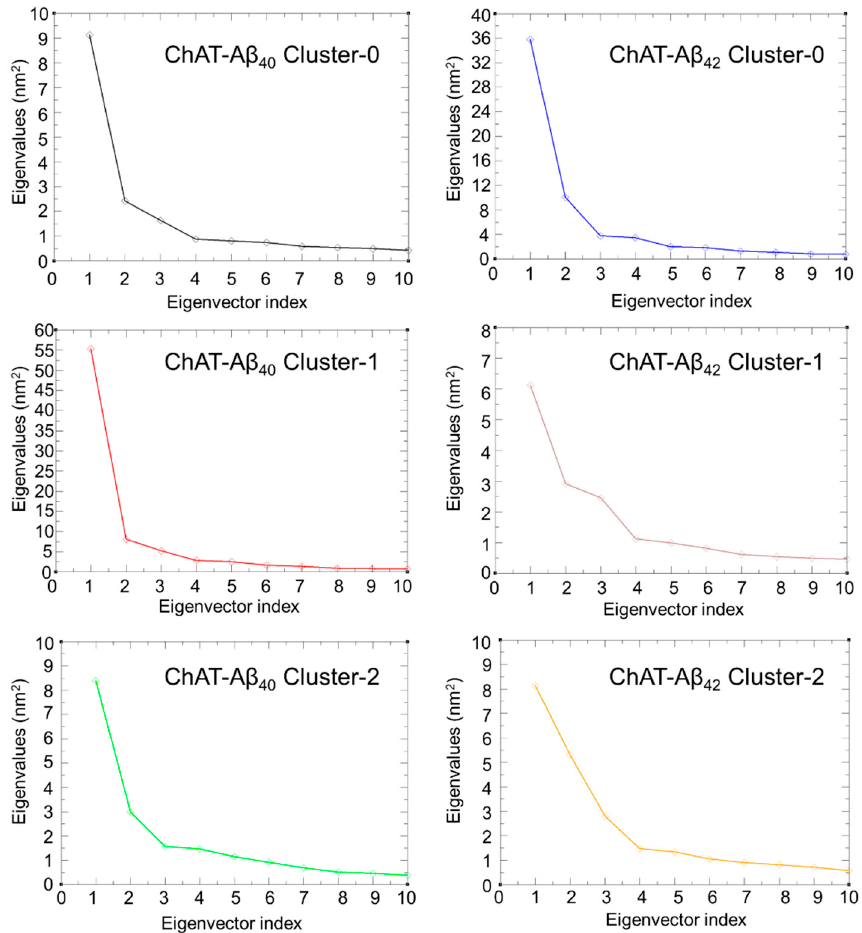
Figure 5. This represents the eigenvalues of each principal component for all the ChAT-A β peptides complex simulated systems. Principal component (PC) analysis tries to find combinations of features that leads to the maximum separation between the data points. The analysis suggests that the first three PC eigenvector accounts for most of the motions in the system, while from the fourth PC eigenvector the contribution become less important. We used the first two PCs to generate the cluster projections by plotting it on x and y axis, respectively, to explain the data points.